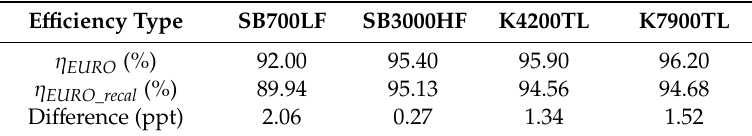
Table 4. Di ff erences between η EURO from the datasheet and η EURO_recal